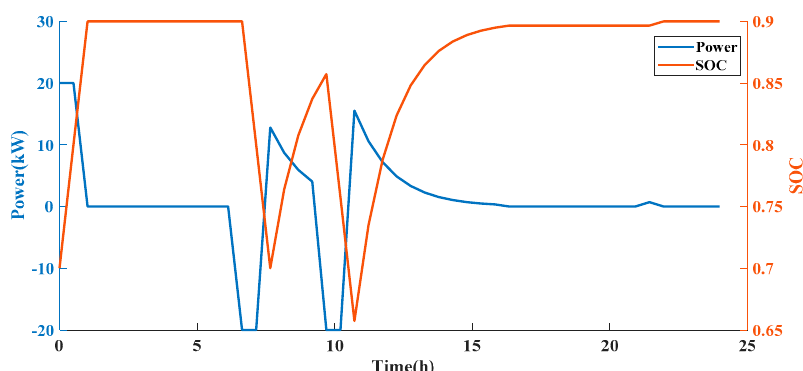
Figure 11. The output of each unit of the parking lot.